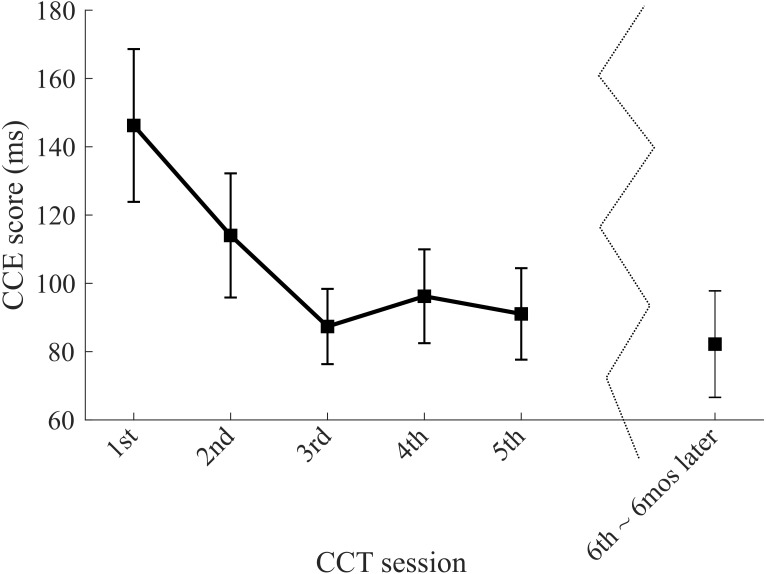
Persistent CCT learning effect after 6-month follow-up testing.Eight subjects from Experiment 1 returned for a sixth visit about 6 months after their initial visits. Data shown are means and standard error for those eight subjects. Results from Experiment 2.